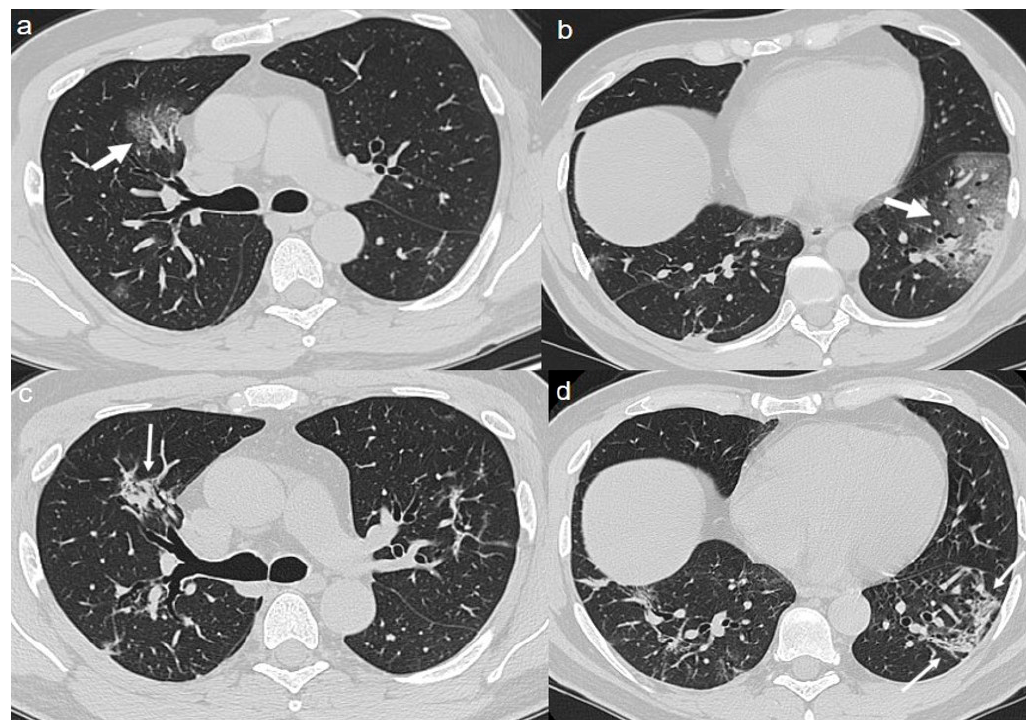
Figure 4. ( a , b ) CT shows patchy areas of GGO with in the upper lobes (arrows). ( c , d ) CT after 4 months from the onset of symptoms shows bilateral persistence of fibrotic stripes in upper lobes (thin arrows).